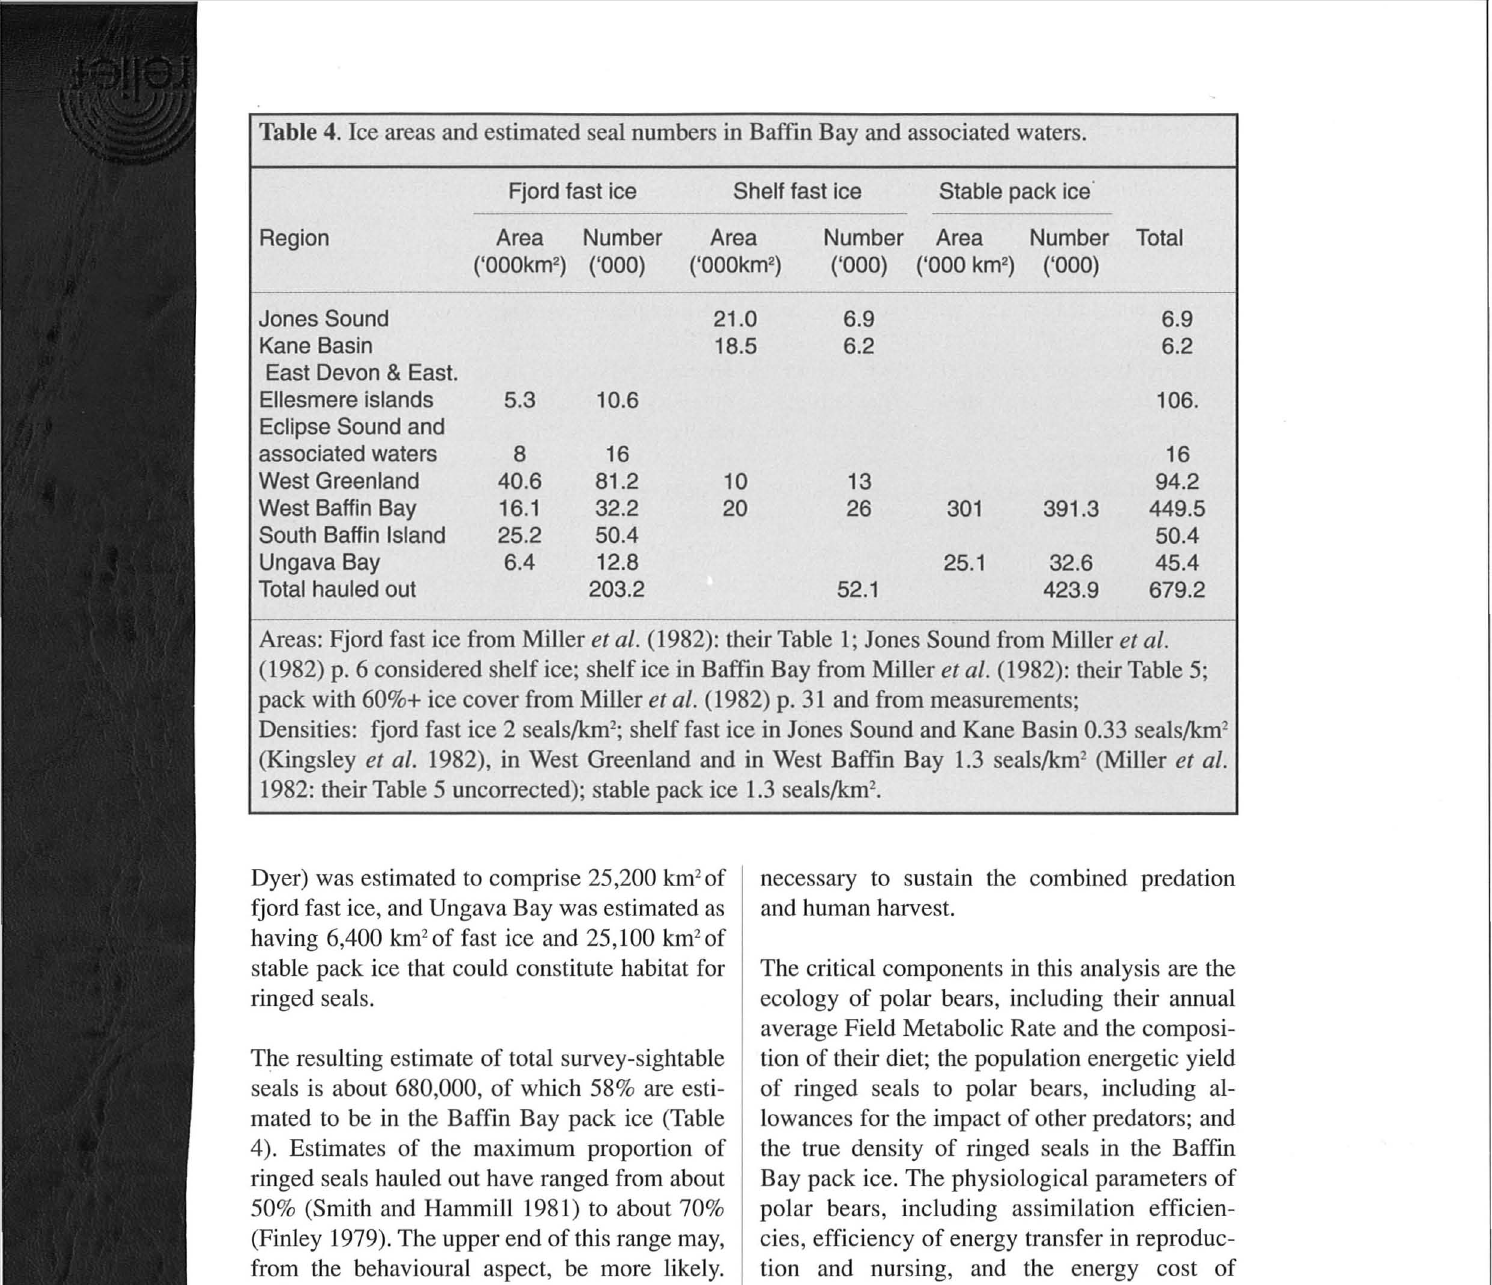
Table 4. Ice areas and estimated seal numbers in Baffm Bay and associated waters. Fjord fast